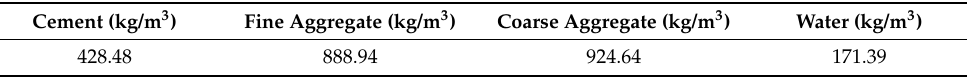
Table 1. Mix design for M30 grade concrete.